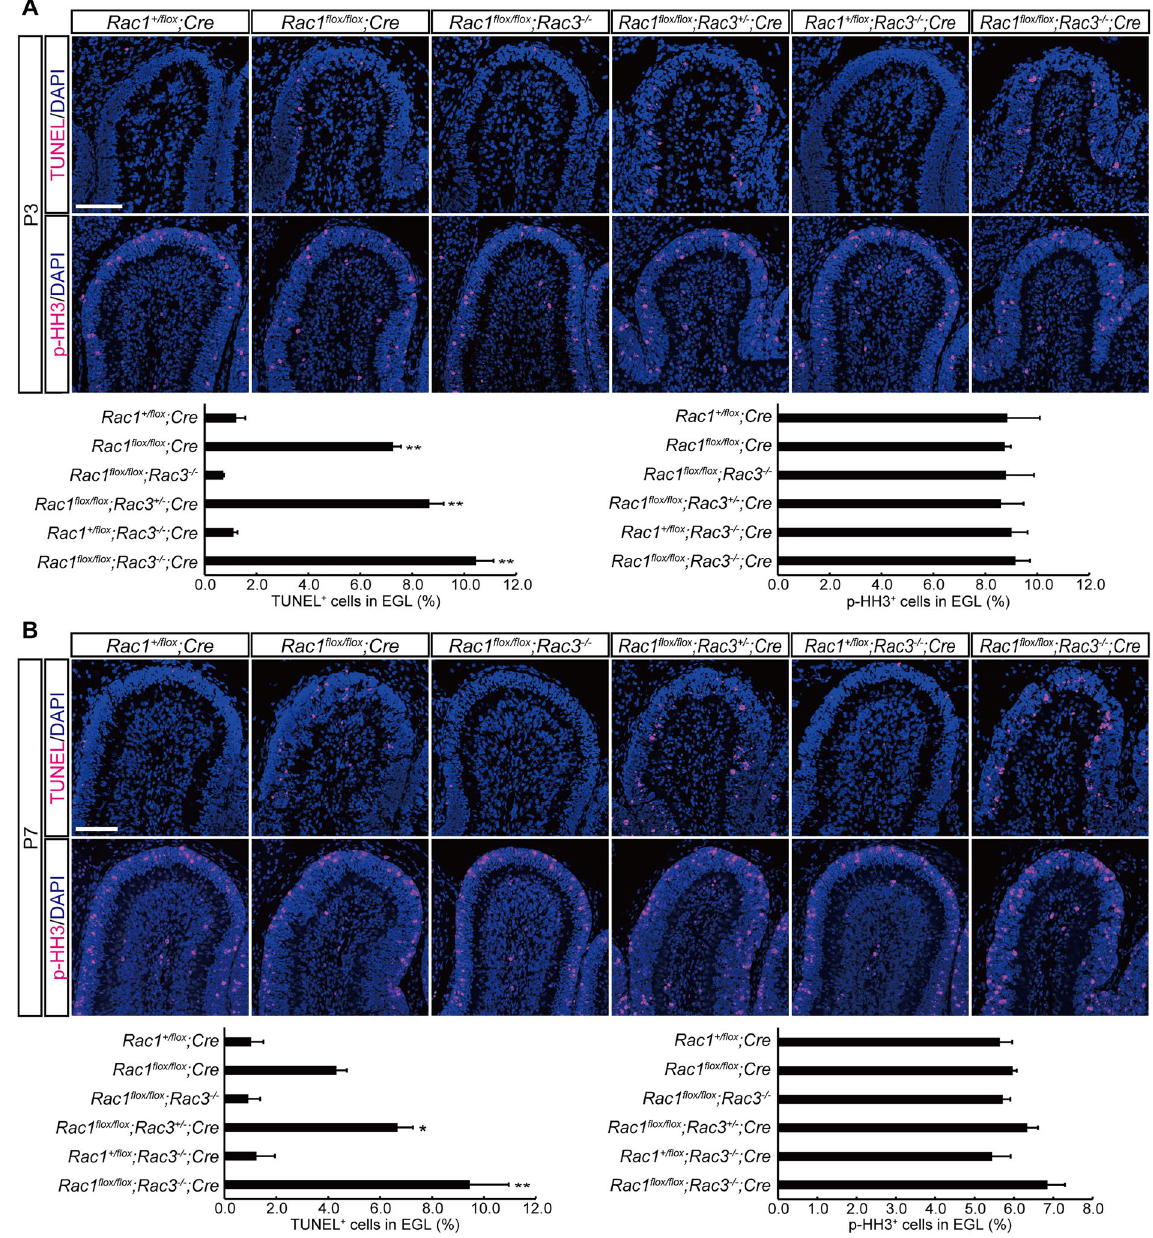
Figure 2. Enhanced apoptotic cell death in the EGL of Rac1 flox/flox ; Rac3 +/− ; Cre and Rac1 flox/flox ; Rac3 −/− ; Cre mice. TUNEL-staining and immunohistochemistry for phospho-histone H3 (p-HH3) of the sagittal section of the lobule IV/V on P3 ( A ) and P7 ( B ). The proportion of TUNEL-positive apoptotic cells was markedly increased in Rac1 flox/flox ; Rac3 +/− ; Cre and Rac1 flox/flox ; Rac3 −/− ; Cre mice, whereas that of p-HH3-positive mitotic cells was largely unaffected. Graphs depict the fraction of TUNEL-positive cells and p-HH3-positive cells in the EGL. Each bar represents mean + SD (n = 3). * P < 0.05, ** P < 0.01 (significantly different from Rac1 + /flox ; Cre mice), one-way ANOVA followed by a Tukey’s post hoc test. Scale bars, 100